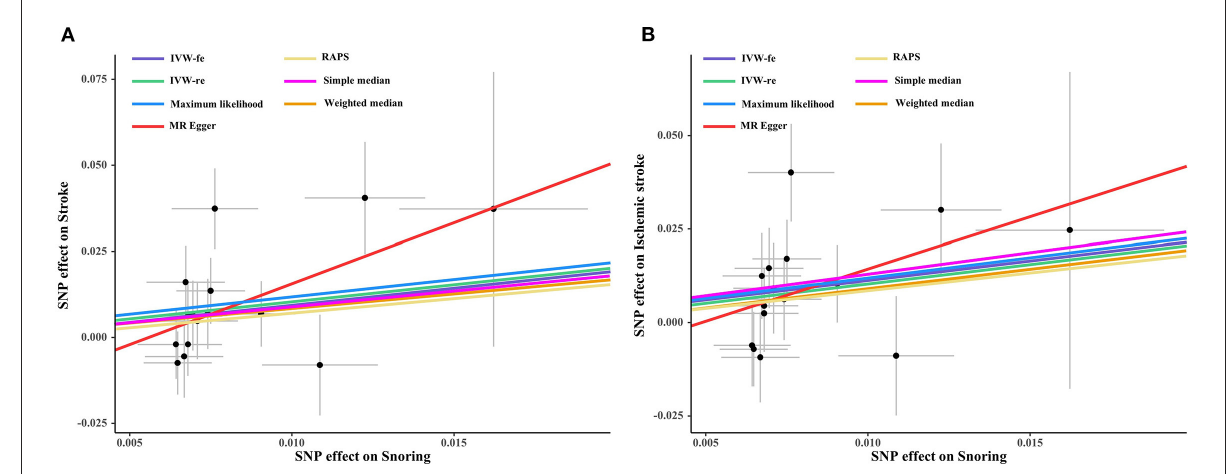
FIGURE2 Scatter plot of the effect size of each SNP on snoring, stroke (A) and IS (B) in SVMR. SNP, single nucleotide polymorphism; IS, ischemic stroke; IVW, inverse variance weighted method; MR, Mendelian randomization.